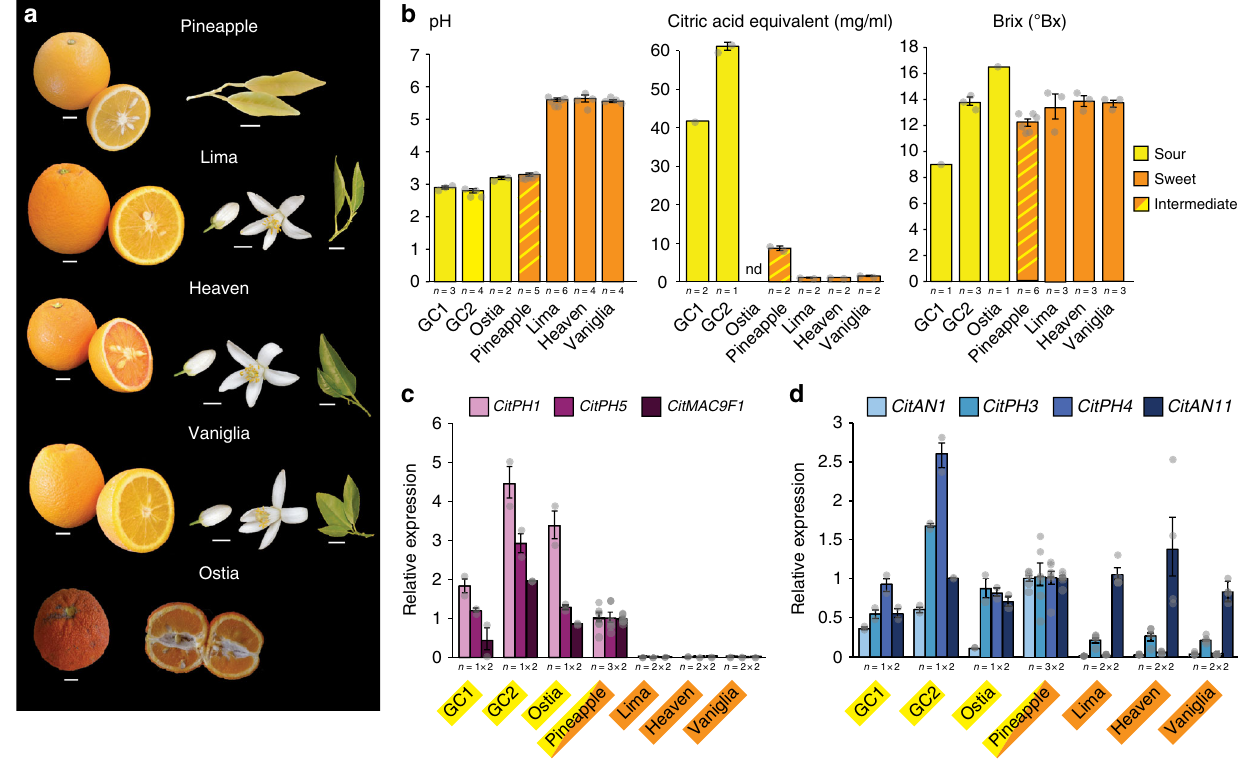
Fig. 5 Analysis of sweet and sour orange varieties. a Fruits, fl ower, and leaf phenotypes of the analyzed varieties. Size bars represent 1 cm. b pH, titratable acid, and soluble solid content (°Brix) in juice from full colored mature fruits (mean ± SE; n ≥ 3). Note that titratable acid was not determined for Ostia (nd). c Real-time RT-PCR of CitPH1 , CitPH5 , and CitMAC9F1 mRNA in juice vesicles from full colored mature fruits. d Real-time RT-PCR of CitAN1 , CitPH3 , CitPH4 , and CitAN11 mRNA in juice vesicles from full colored mature fruits. Values in c , d are mean ± SE; n = number samples from different fruits × number of technical replicates of each. Source data are provided as a Source Data fi